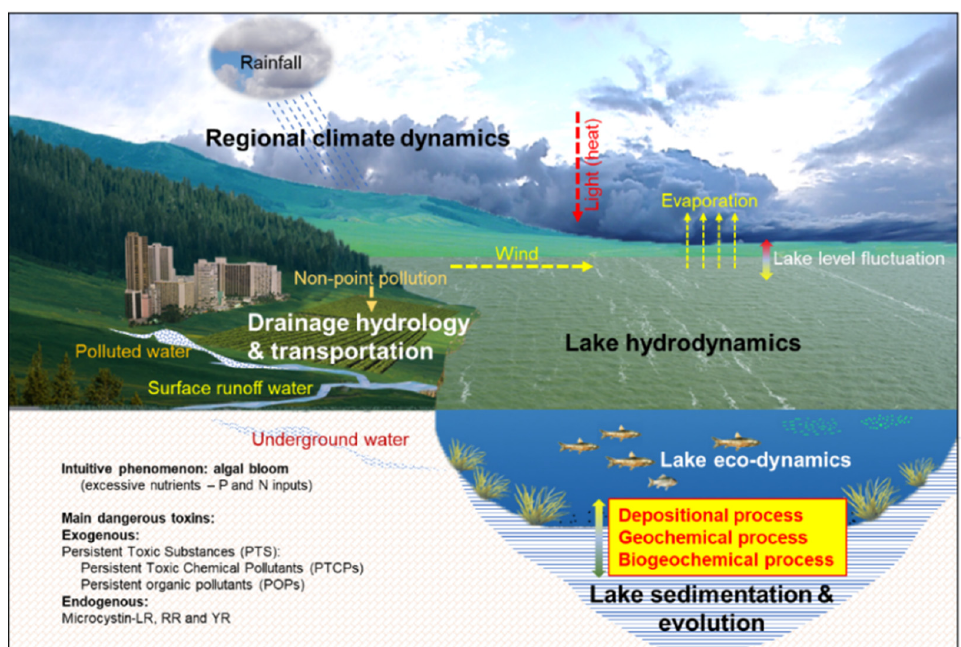
Figure 1. Watershed lake systems and main processes.